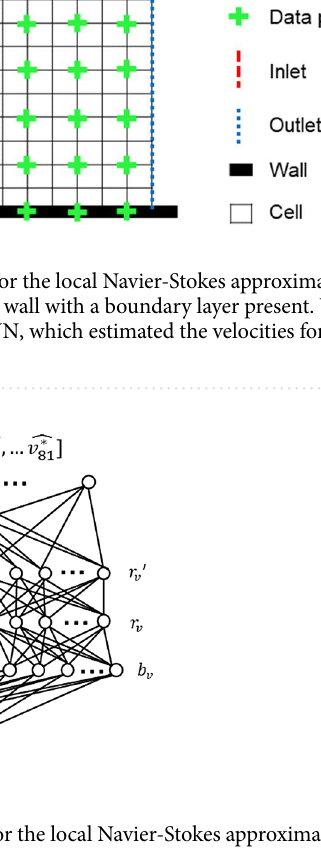
Figure 3. A modified KBaNN architecture was used for the local Navier-Stokes approximator. It was found that training a separate set of boundary and region neurons for each velocity component was more efficient (fewer neurons were required overall) than the general KBaNN architecture illustrated in Fig. 1